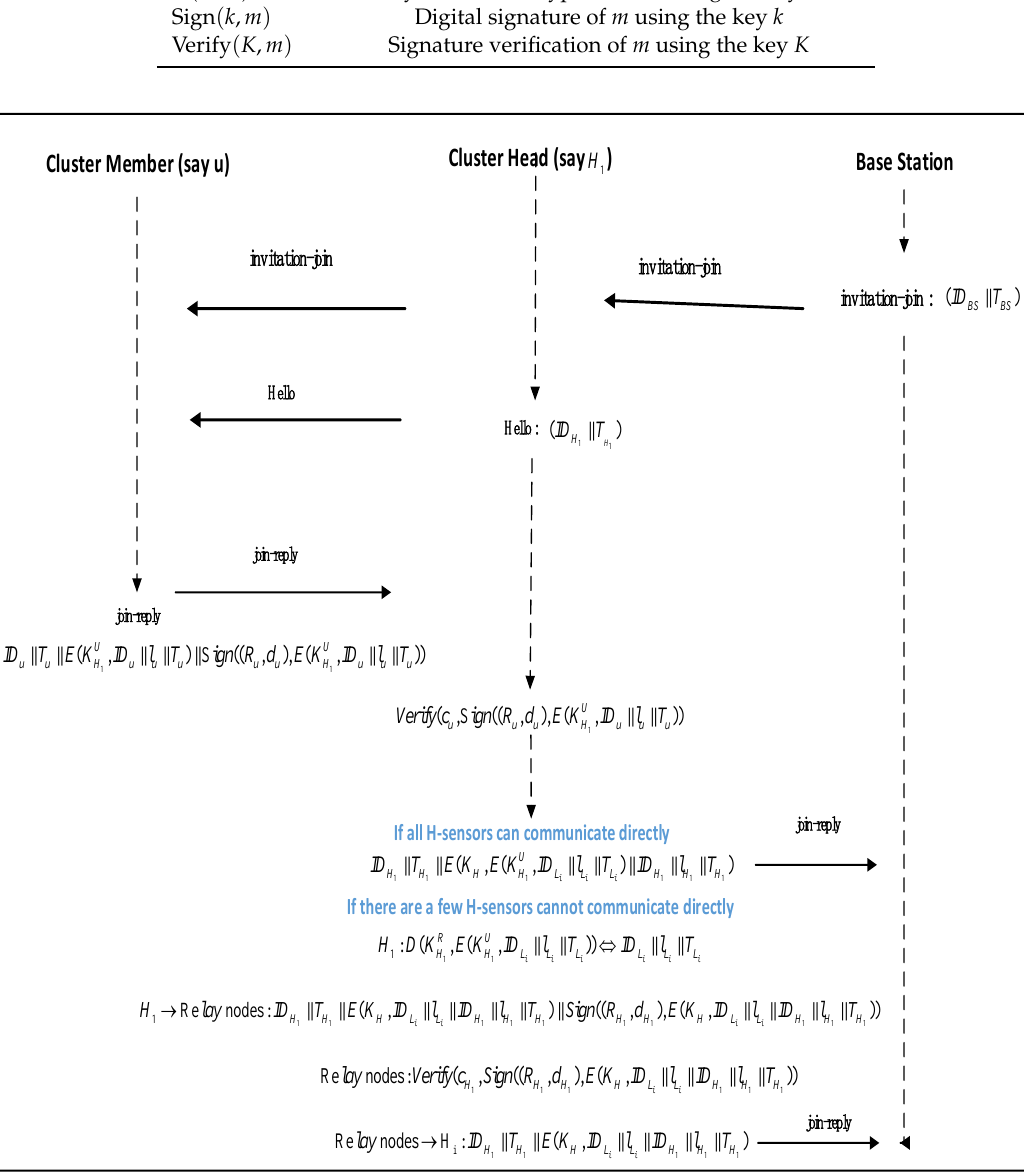
Figure 2. The process of nodes in the network uploading their own location information.